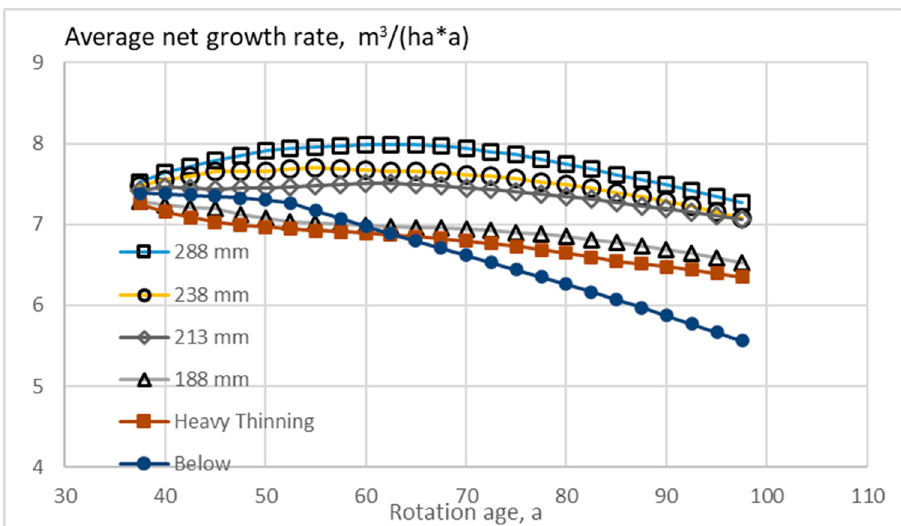
Figure 9. The expected value of the net annual growth rate for six different treatment schedules applied on a normal stand representing the example estate. The growth rate is integrated over stand age until any rotation age.